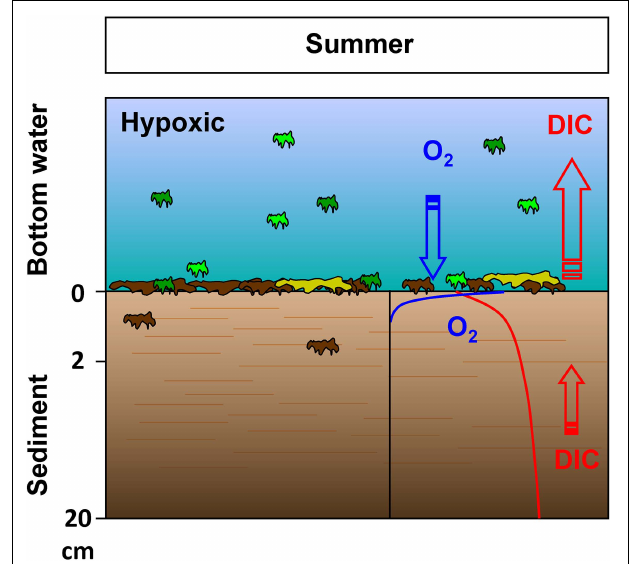
FIGURE 9 | Proposed conceptual model for the summer period: The generally low bioturbation throughout the year and its decrease in summer, concomitantly with the increase in organic matter deposition from the water column, limits organic matter penetration into the sediment by reducing the mixing of new particles with the deeper sediments (horizontal red bars indicate horizontally-layered structure with limited transport). The transport of reactive organic matter is thus limited throughout the year and especially in summer during hypoxic periods, therefore generating a biogeochemically inactive sediment interior (small red arrow in the sediment indicating low DIC internal production) and an active sediment-water interface with important mineralization (large red arrow for total DIC